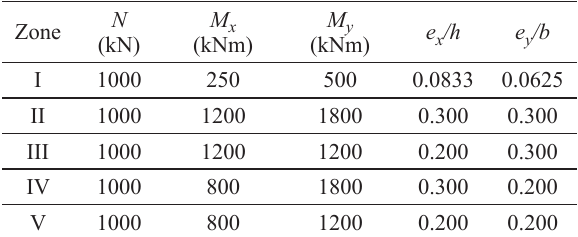
Rotational spring constants of rectangular rigid footing (Fig. 11) resting on tensionless Winkler-type soil have been achieved under the external forces corresponding to five different zone (Fig. 4) seen in Table 3. Table 3. The forces and bending moments on rectangular